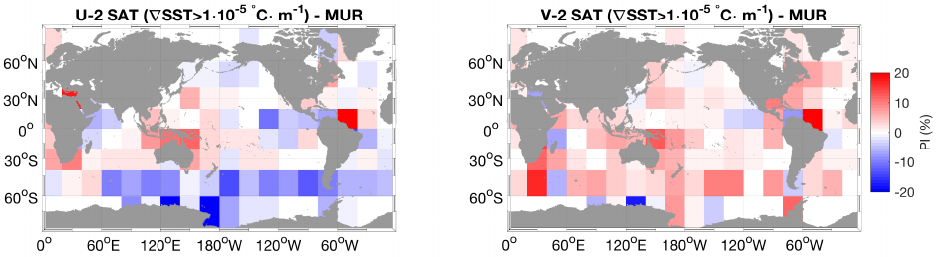
Figure 3. Same as Figure 1. The input SST is Multiscale Ultra-high Resolution (MUR).